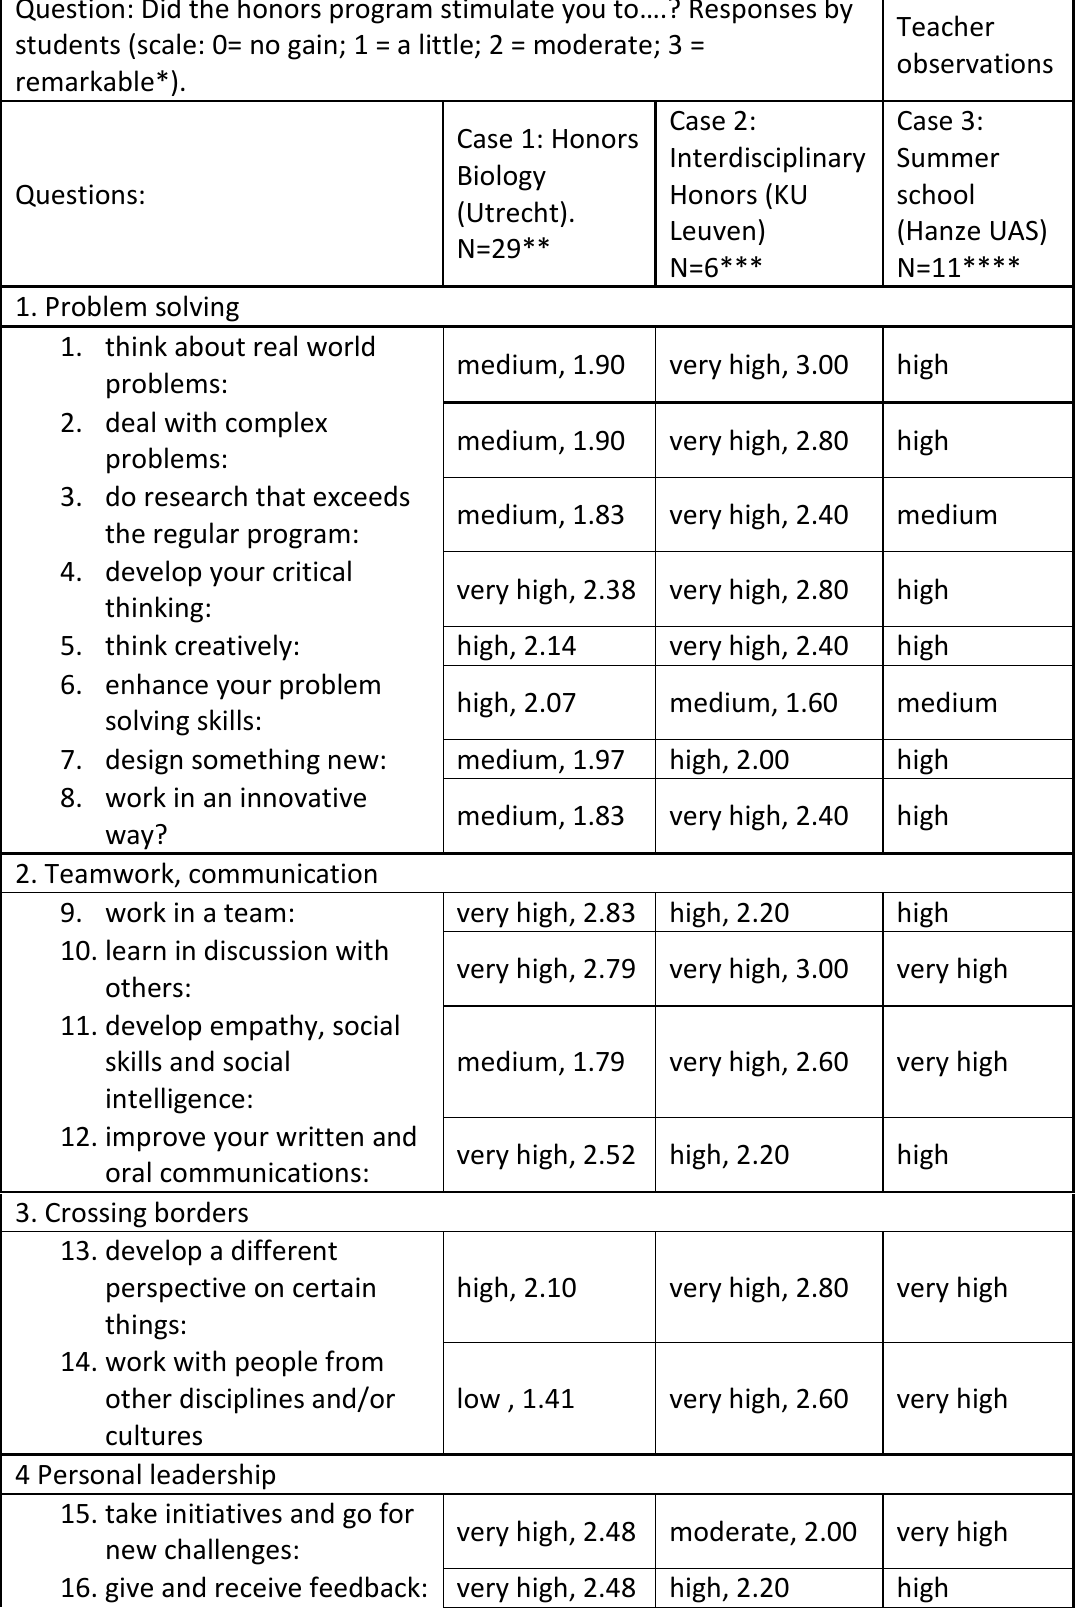
Table 1. Honors programs stimulating development of 21st century skills Question: Did the honors program stimulate you to….? Responses by students (scale: 0= no gain; 1 = a little; 2 = moderate; 3 =